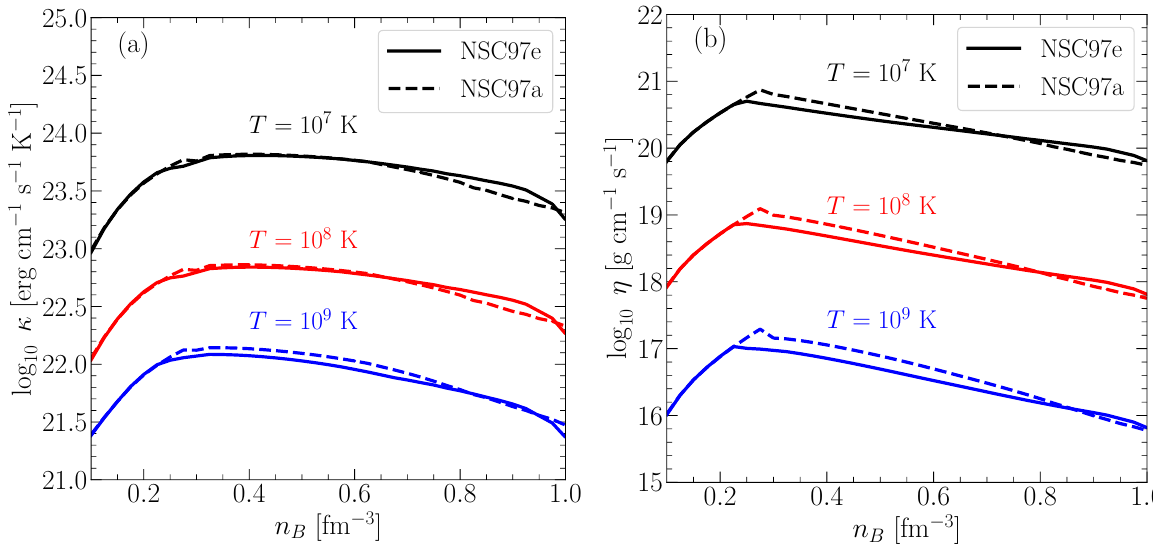
Figure 9. Total thermal conductivity ( a ) and shear viscosity ( b ) in hypernuclear NS cores for the NSC97e (solid lines) and NSC97 (dashed lines) models. Here we do not perform temperature rescaling of the transport coefficients. The results are shown for three values of temperature, T = 10 7 , 10 8 , and 10 9 K as indicated in the